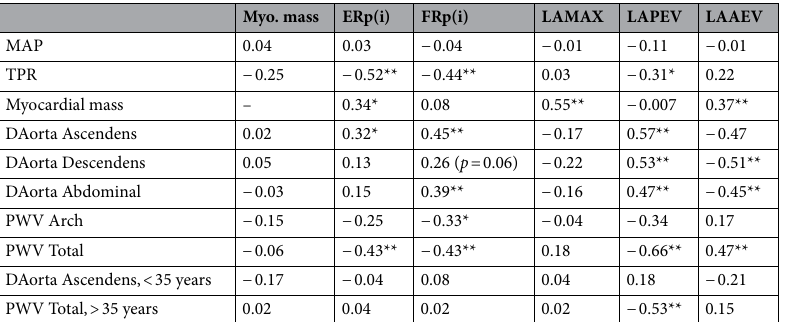
Table 3. Correlations of arterial characteristics to variables related to LV systolic and diastolic function. Correlations of blood pressure (MAP), total peripheral resistance (TPR), Pulse wave velocity (PWV) and